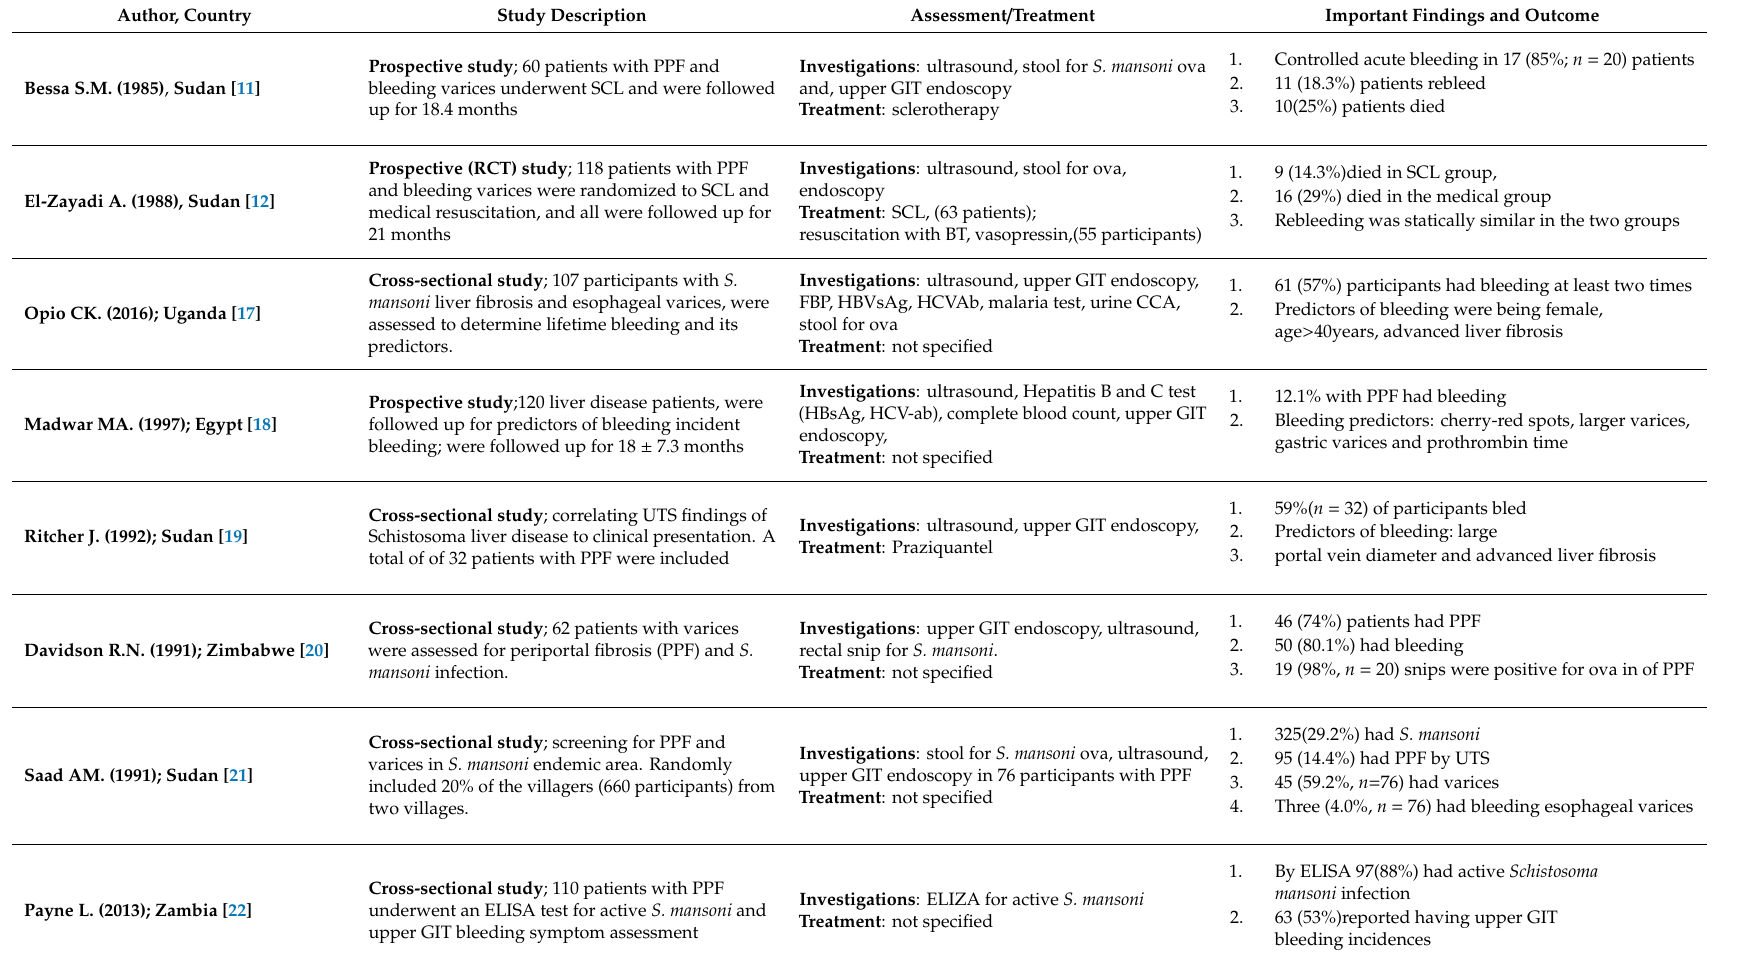
Table 1. Study objectives, design, outcomes, and predictors among 22 studies included in the